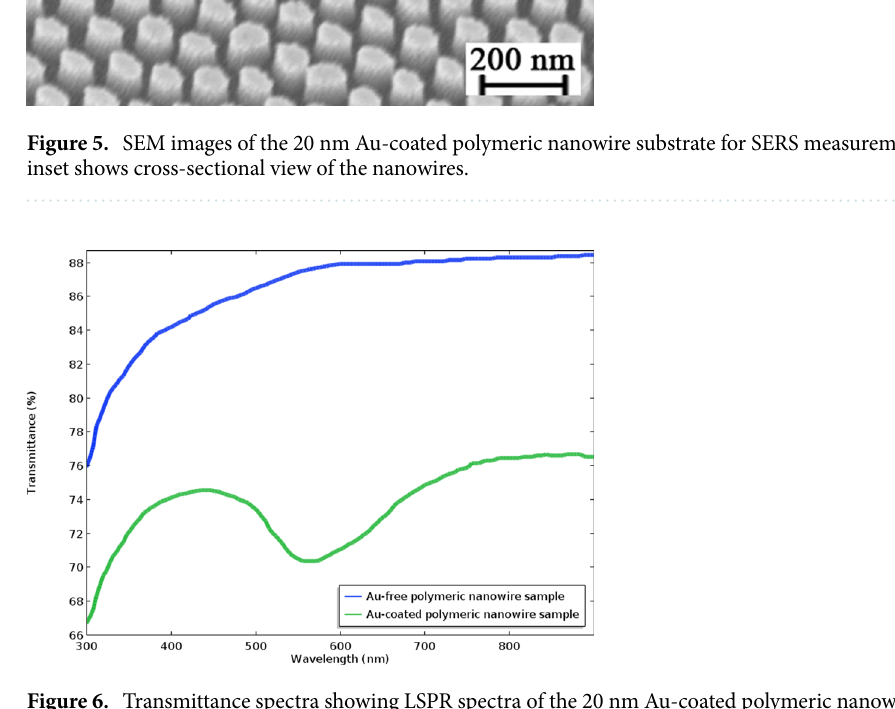
Figure 6. Transmittance spectra showing LSPR spectra of the 20 nm Au-coated polymeric nanowire sample and Au-free polymeric nanowire sample (with the diameter of ~ 80 nm and length of ~ 300